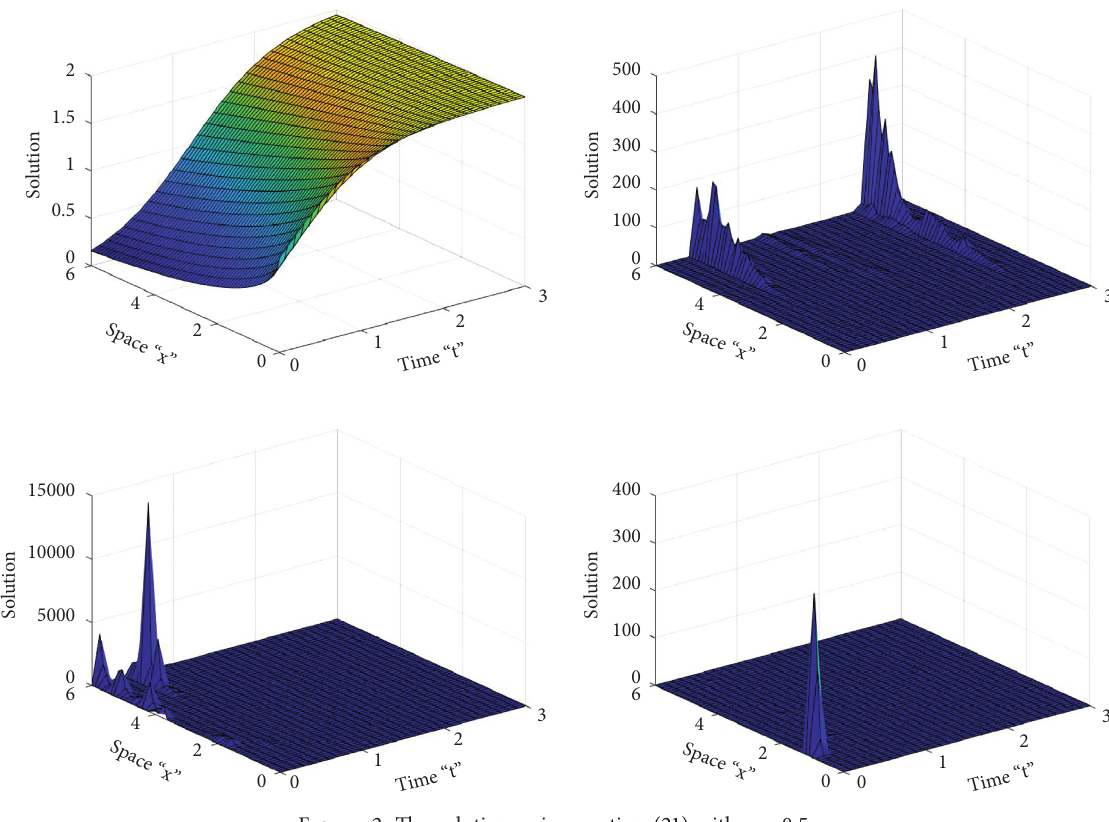
Figure 2: The solution w in equation (21) with α � 0 . 5.